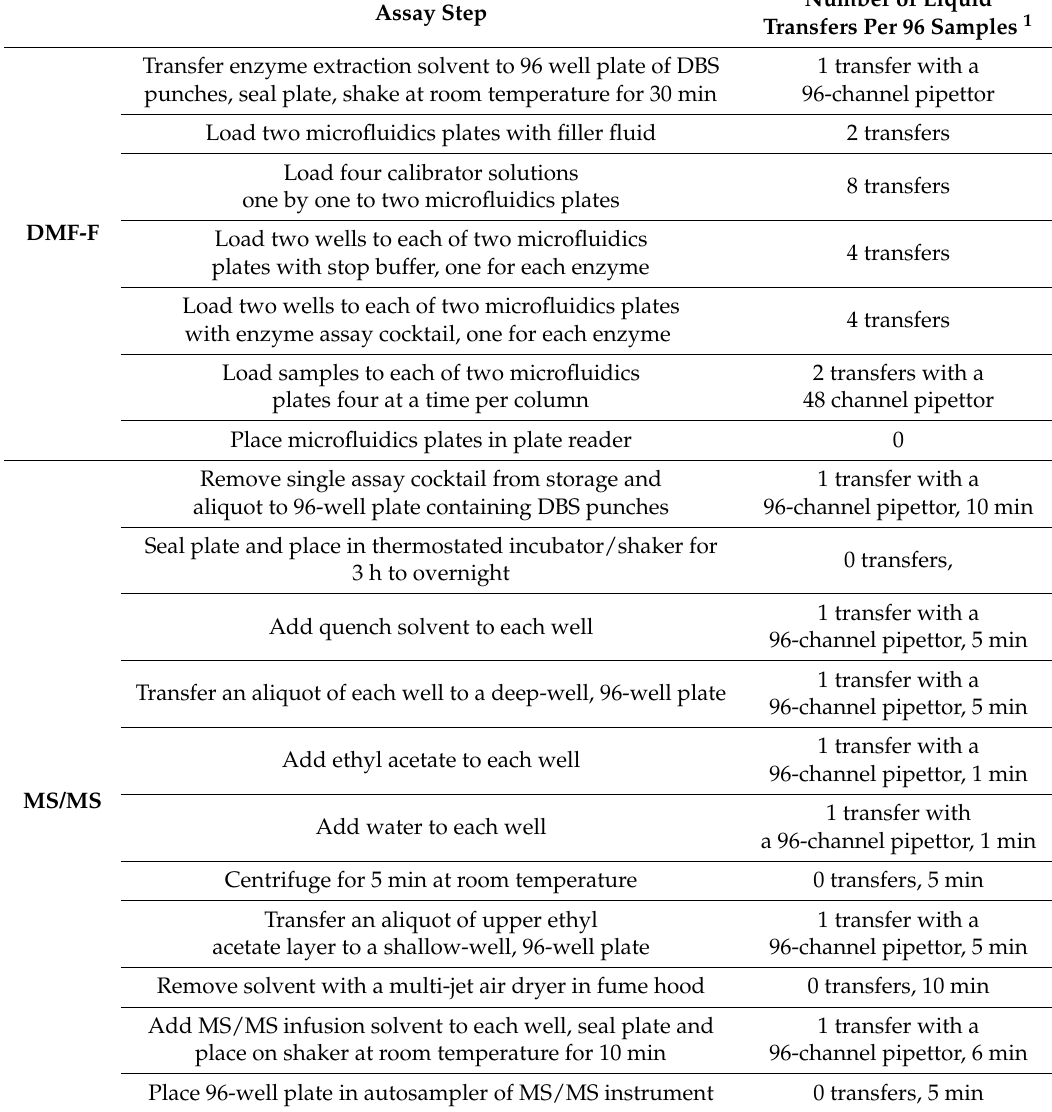
Table 1. Summary of the workflows for mass spectrometry (MS/MS) and digital microfluidics blood spots (DBS). Hands-on time per step is given for the MS/MS assay